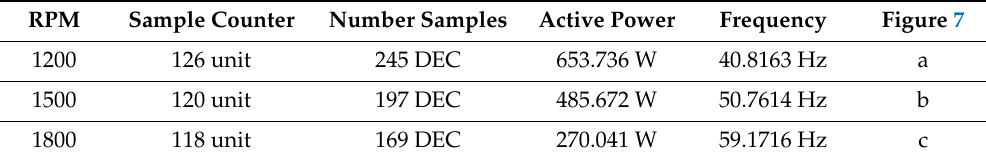
Table 1. Supplementary details of Figure 7.